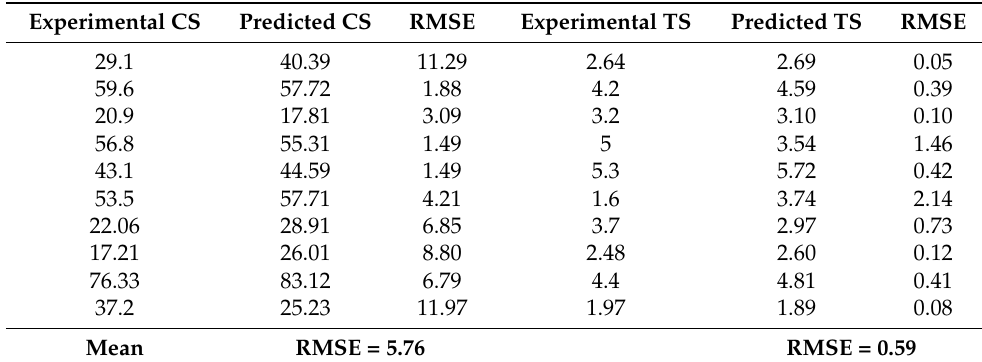
Table 8. Cross-validation of tacked-together outputs upon the prediction of compressive and ten- sile